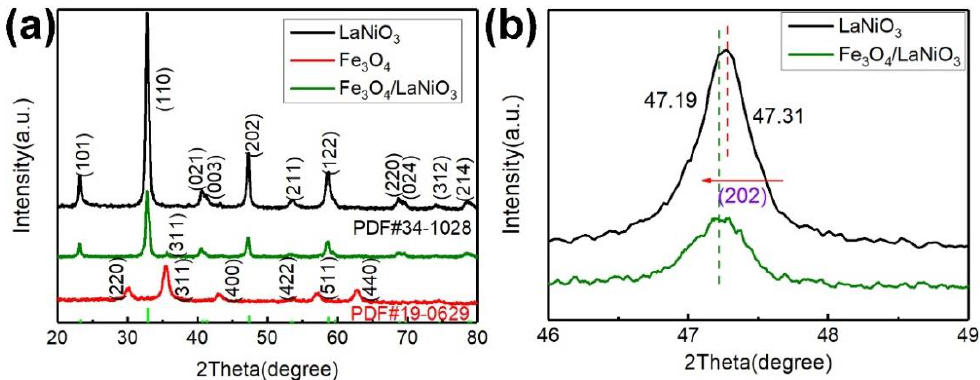
Figure 1. XRD patterns of LaNiO 3 , Fe 3 O 4 catalyst and Fe 3 O 4 /LaNiO 3 catalyst: ( a ) full spectrum; ( b ) partial view.